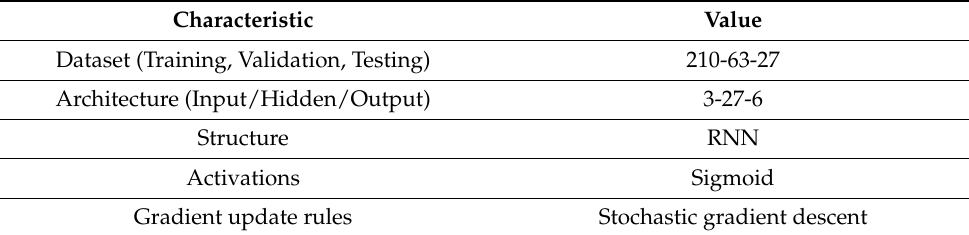
Table 8. Summary of the ANN characteristics.